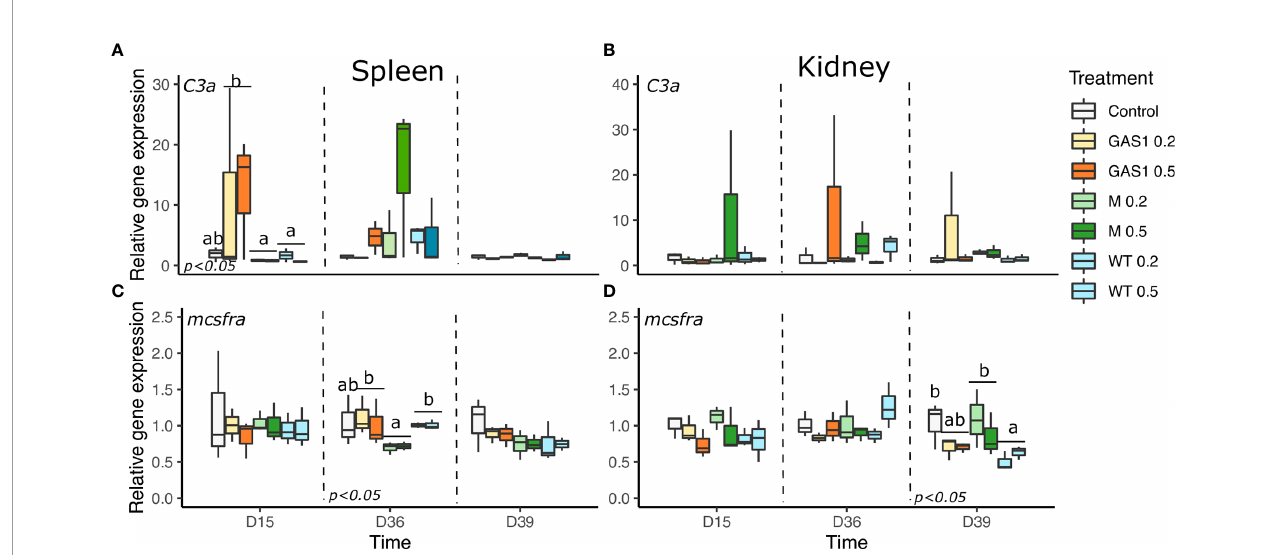
FIGURE 5 | Effects of dietary beta glucan on C3a complement ( c3a ) and macrophage colony-stimulating factor receptor a ( mcsfra ) genes expressions in the spleen and kidney of fi sh sampled during the nutrient test on D15 and D36, or 2 days after the bacterial challenge (D39). (A – D) are expression levels of c3a and mcsfra in spleen and kidney, respectively. Relative transcript (mRNA) levels were determined by real-time RT-PCR and normalized by the arithmetic mean of ef-1 a expression. Values are expressed as mean ± SD of three pool samples per experimental condition (3 fi sh per pool sample). Statistical differences, highlighted by letters, are indicated for glucan concentrations in front of 0, 0.2, and 0.5% next to the corresponding plot, for glucan type by letter above the horizontal bar grouping the two doses of the same glucan, for glucan type × concentrations interactions above each box. P values are shown at the bottom of each graph at a given time point (D15, D36, or D39).